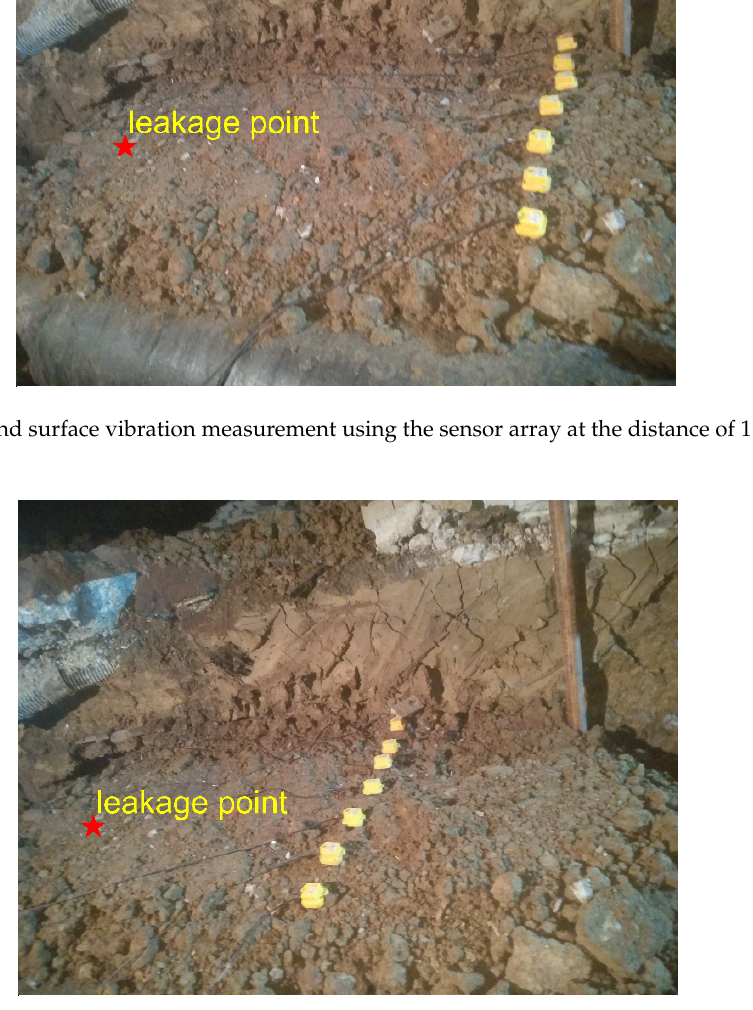
Figure 7 . Ground surface vibration measurement using the sensor array at the distance of 0.5 m from the leak. ( a )